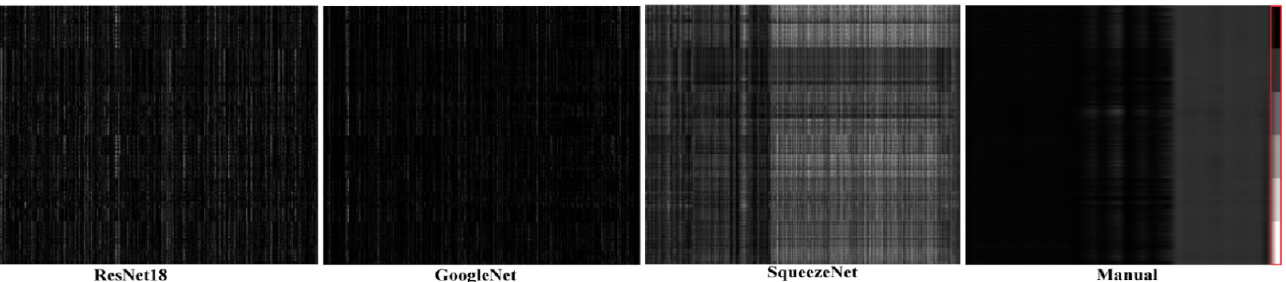
Figure 6. Features visualization of different approaches.